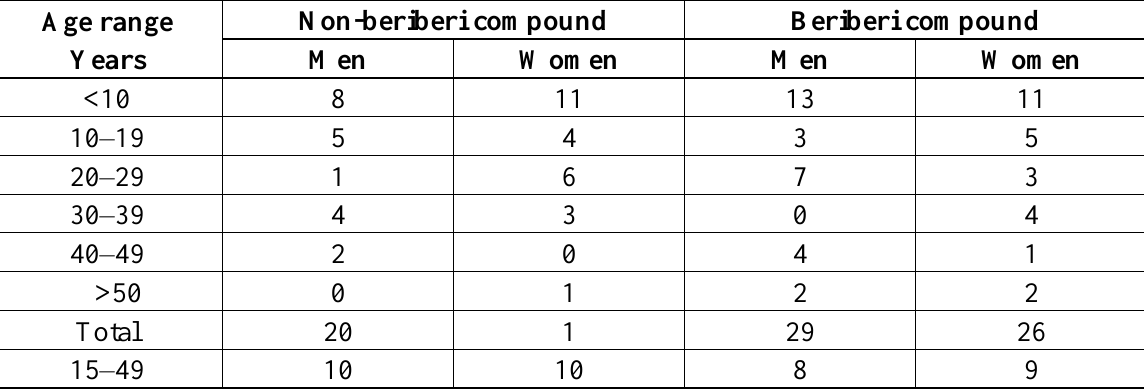
Table 1. Description of inhabitant of the two study compounds in the village of Chilla 1,2